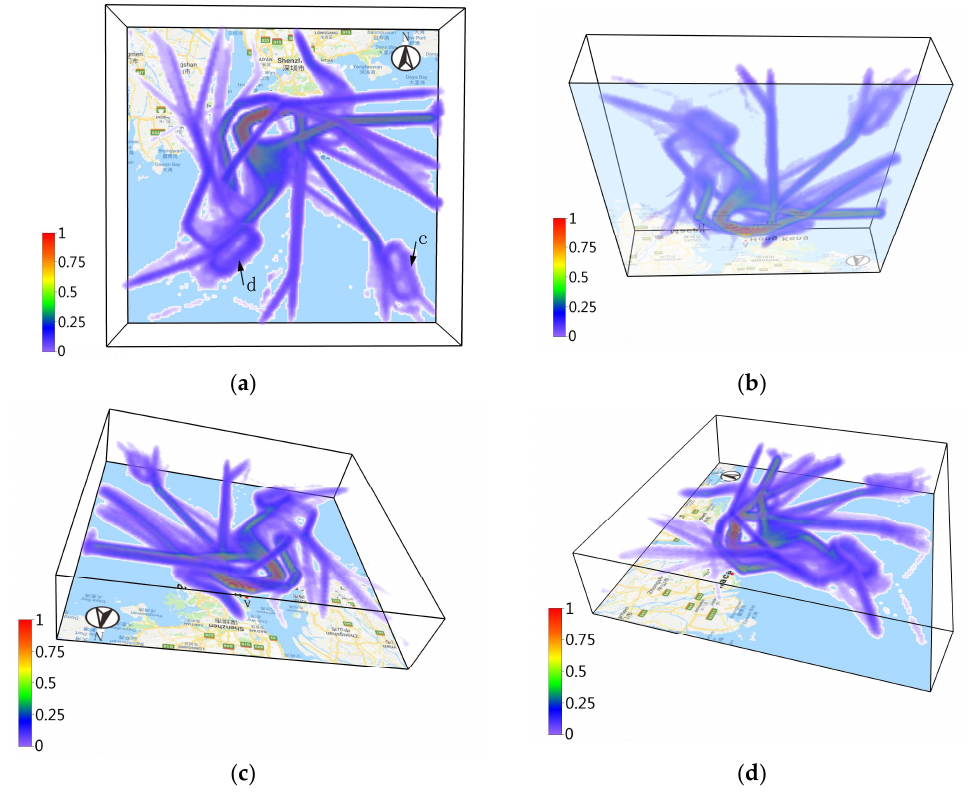
Figure 7. TotalTimeDensity of flights’ movement data displayed in different directions. TotalTimeDensity observed from ( a ) the top view; ( b ) the bottom of the cube and ( c , d ) the side views. The map transparency in ( b ) is set to 35%.